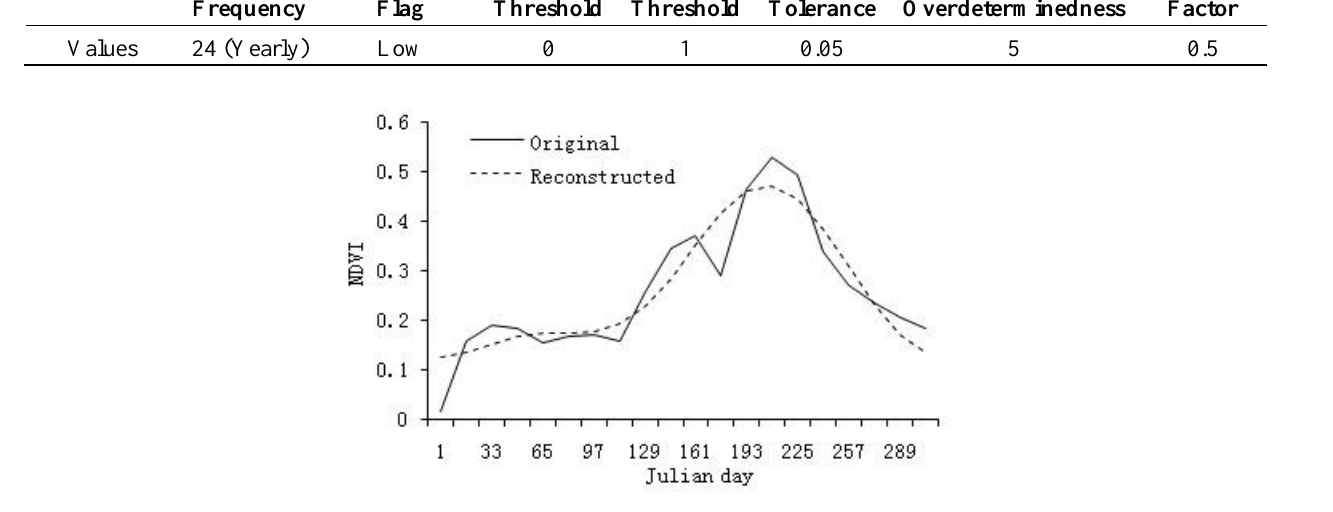
Figure 2. Illustration of NDVI (normalized difference vegetation index) time series reconstruction using the HANTS